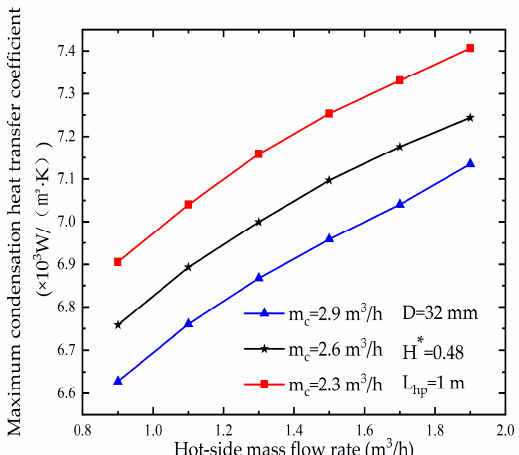
Figure 9. Comparison of maximum condensation heat transfer coefficient with different cold side mass flow rates.